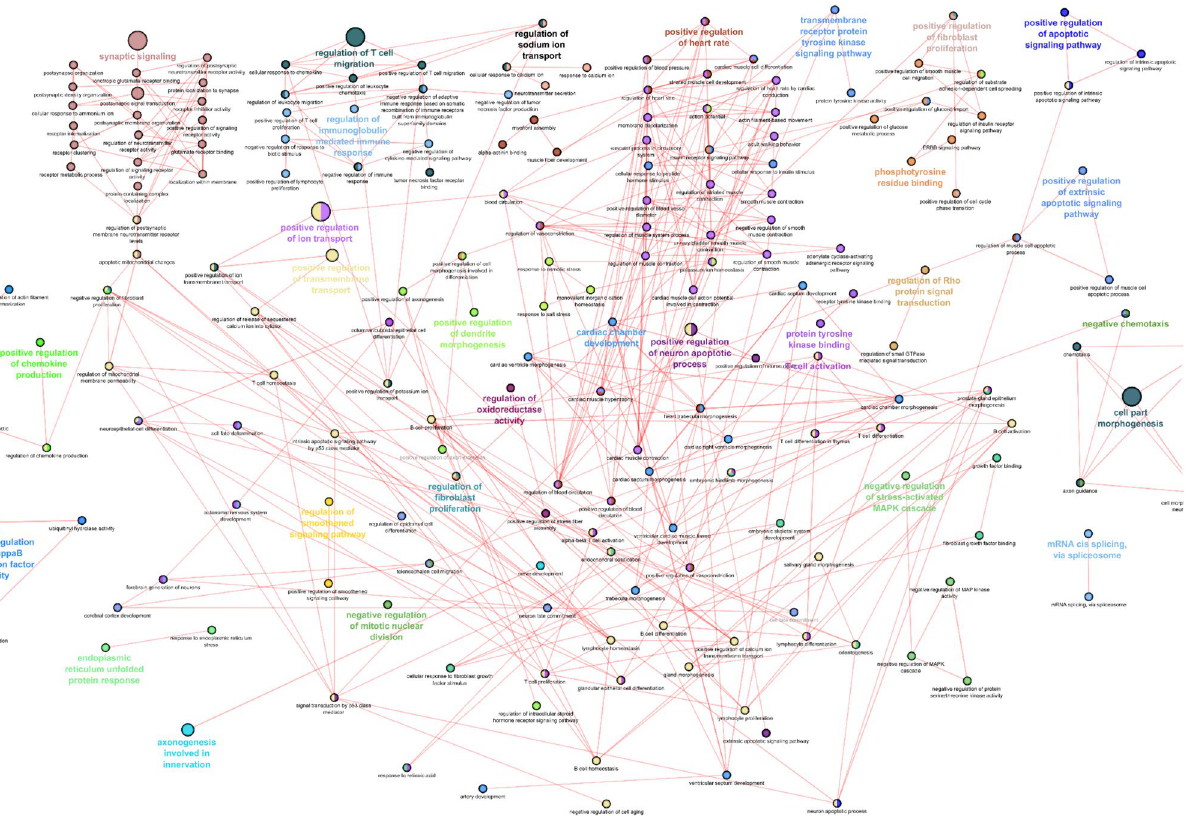
Figure 5. Gene ontology (GO) analysis of top 5 deregulated circulating lncRNAs in db/db mice with diabetic cardiomyopathy. The network represents the GO pathway terms specific for mRNA genes having co-expression relationship with the significantly differentially expressed top 5 lncRNAs having maximum connections in the co-expression network (Pearson correlation > 0.995 or < − 0.995 and P < 0.05) at 20 weeks of ag. Functionally grouped networks with GO terms as node are grouped based on kappa score level (> 0.03), the most significant groups are shown. The node size represents the term enrichment significance. Different GO clusters are shown in different color whereas functionally related groups partially overlap. The color gradient represents the gene proportion of each cluster associated with that term. Nodes indicate lncRNAs or